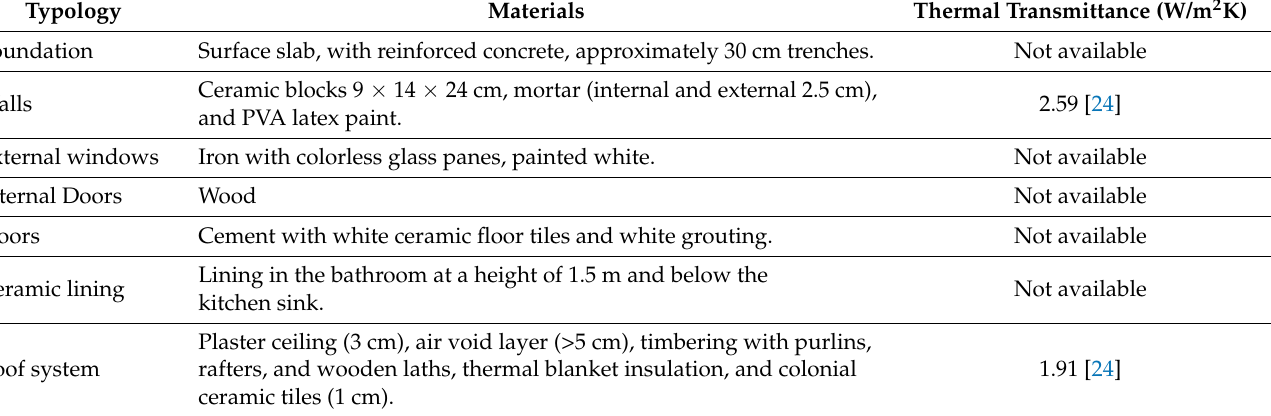
Table 1. Materials